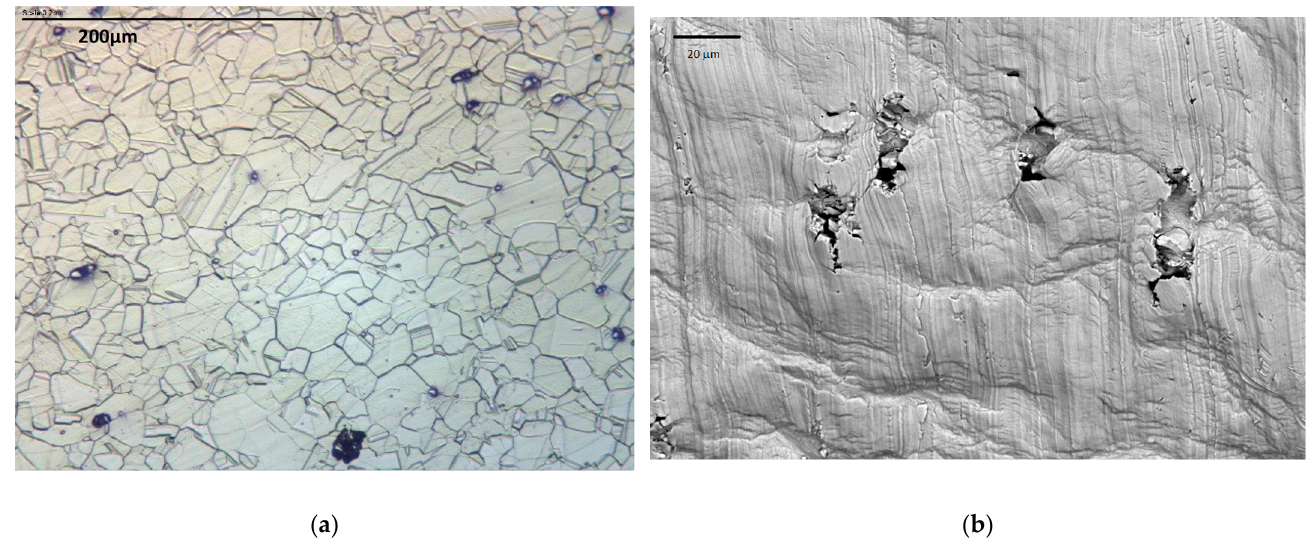
Figure 6. Inconel 718 alloy: ( a ) structure in as-received state (magnification 400×), ( b ) surface of specimen in the neck zone after HCF test—magnification 1500×).